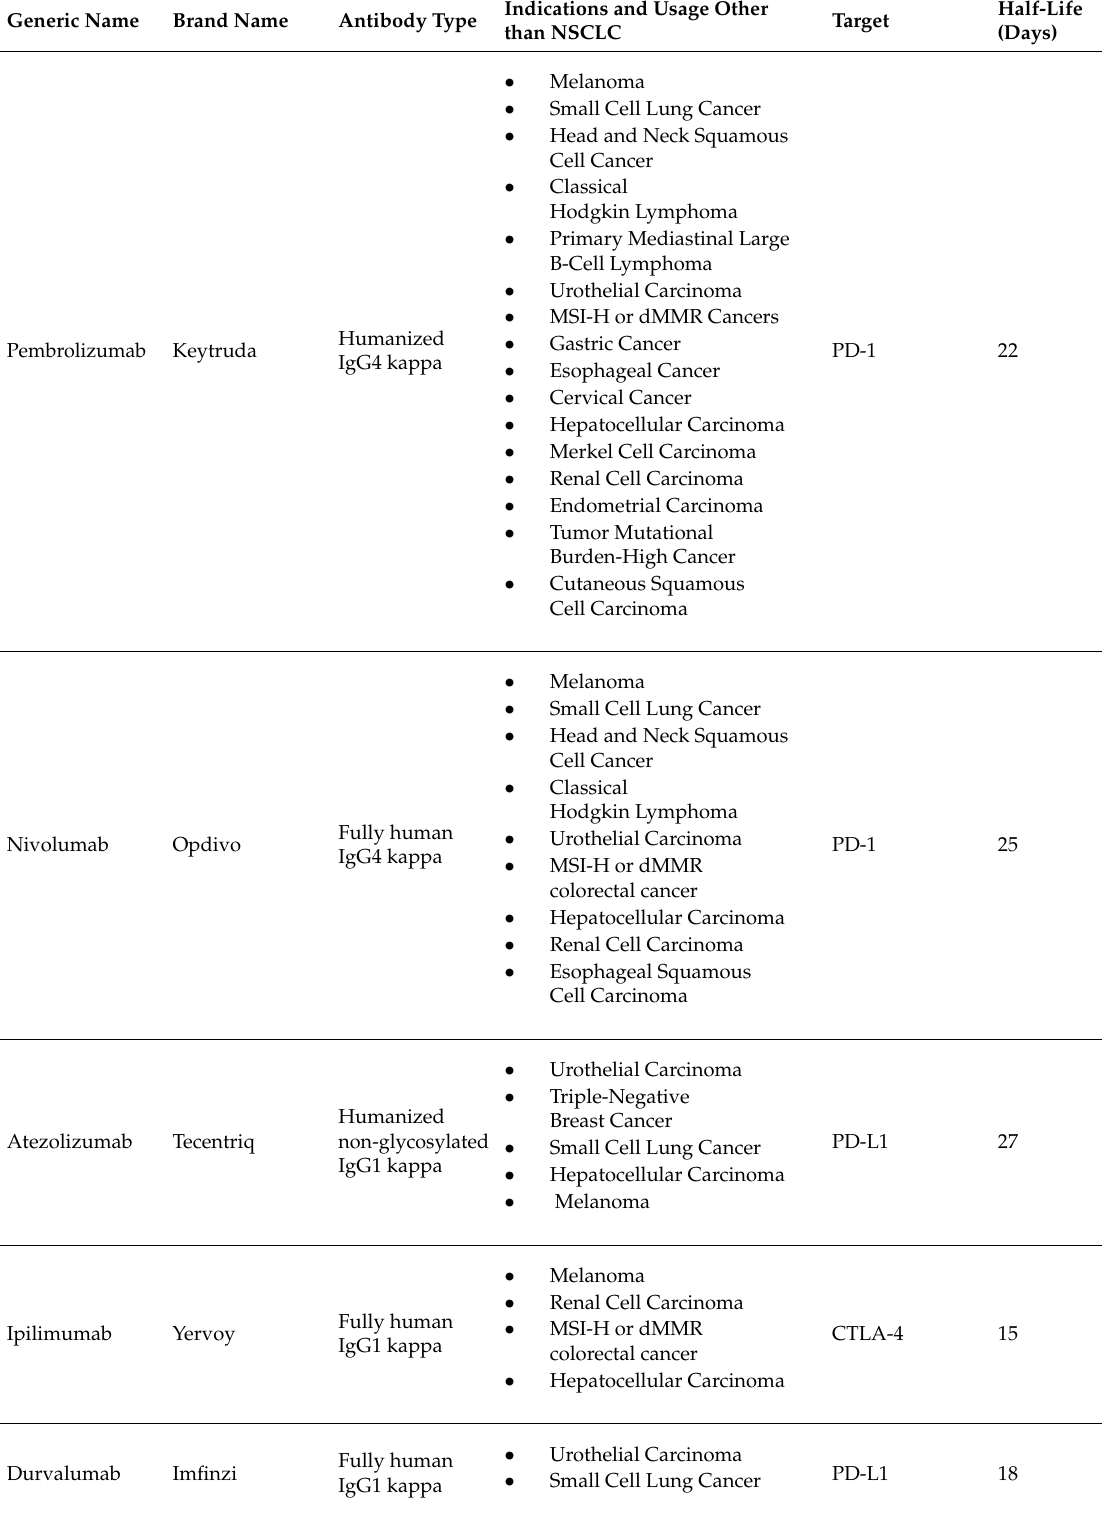
Table 1. Antibodies targeting the immune system used for treatment of lung